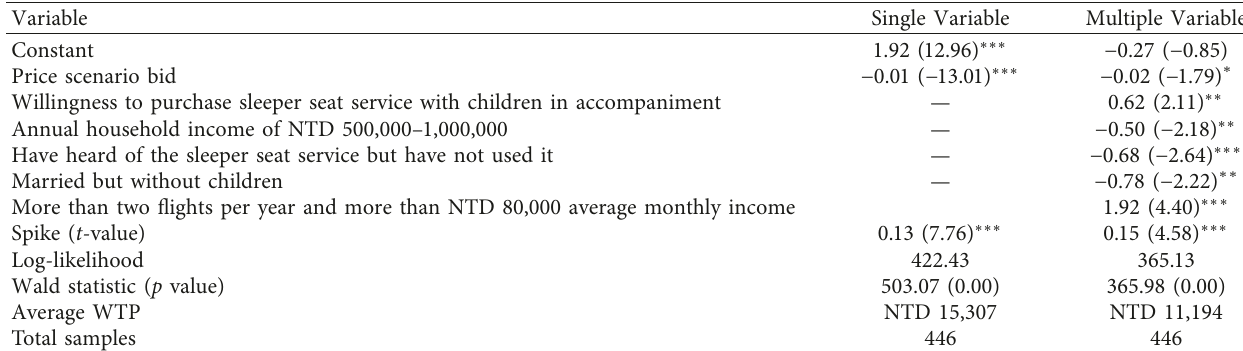
Table 7: Estimation table of the sleeper seat WTP